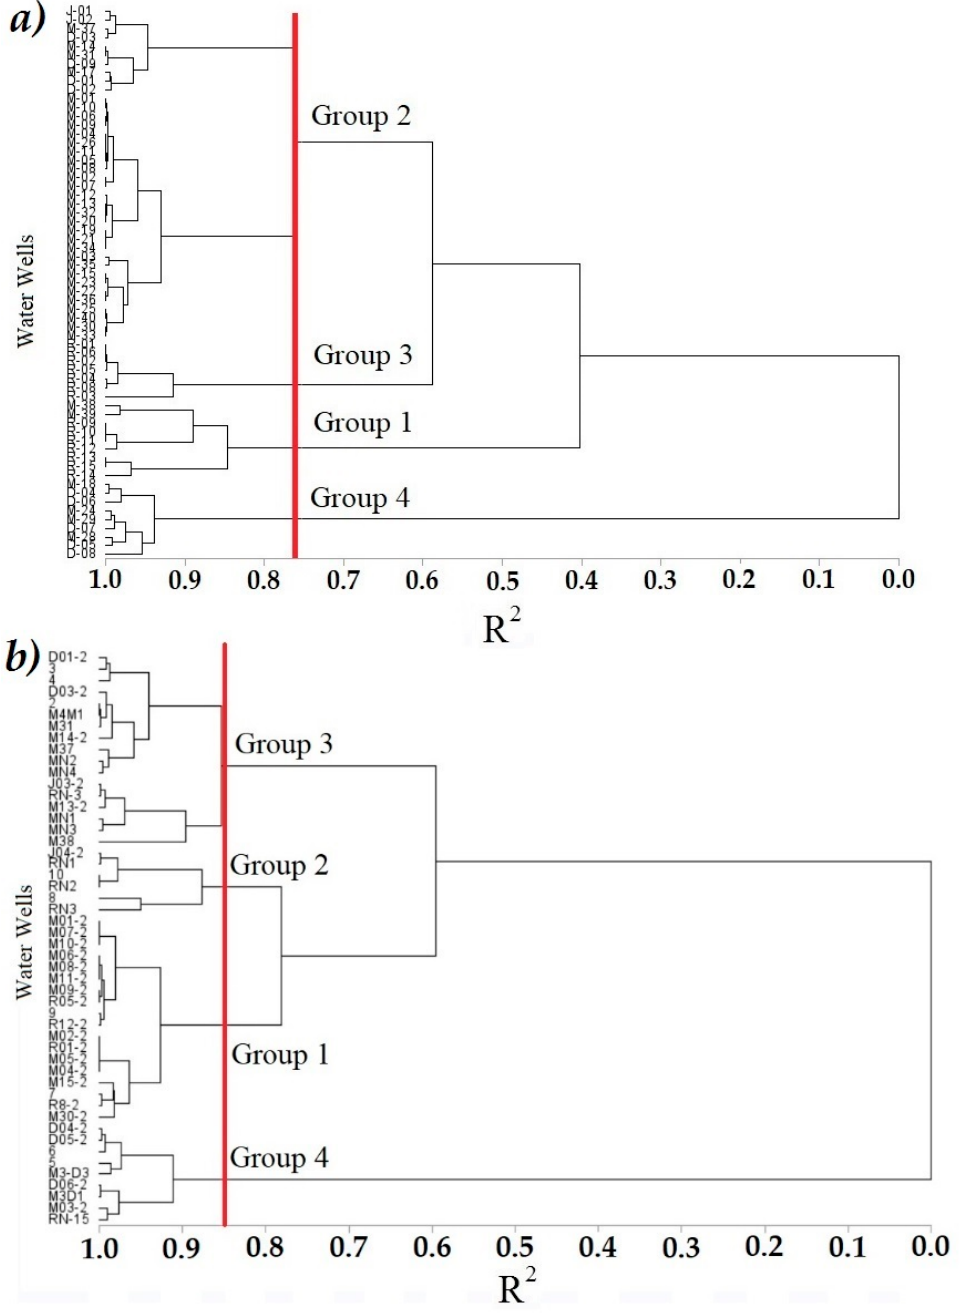
Figure 4. Dendogram. Grouping of sampling sites according to the PhP of the ID005 for S1 ( a ) and S2 ( b ).